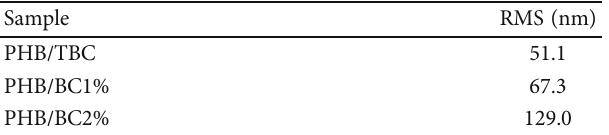
Table 2: Roughness (RMS) values for the samples calculated from AFM analysis.